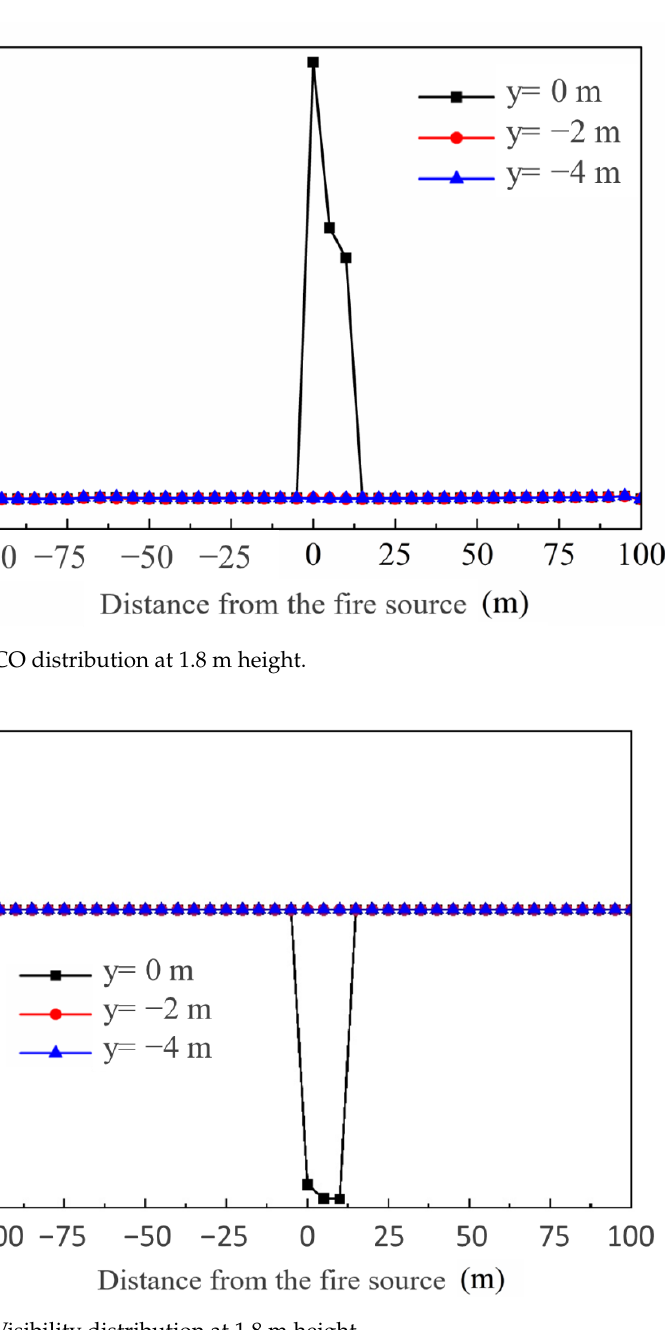
Figure 17. Visibility distribution at 1.8 m height.